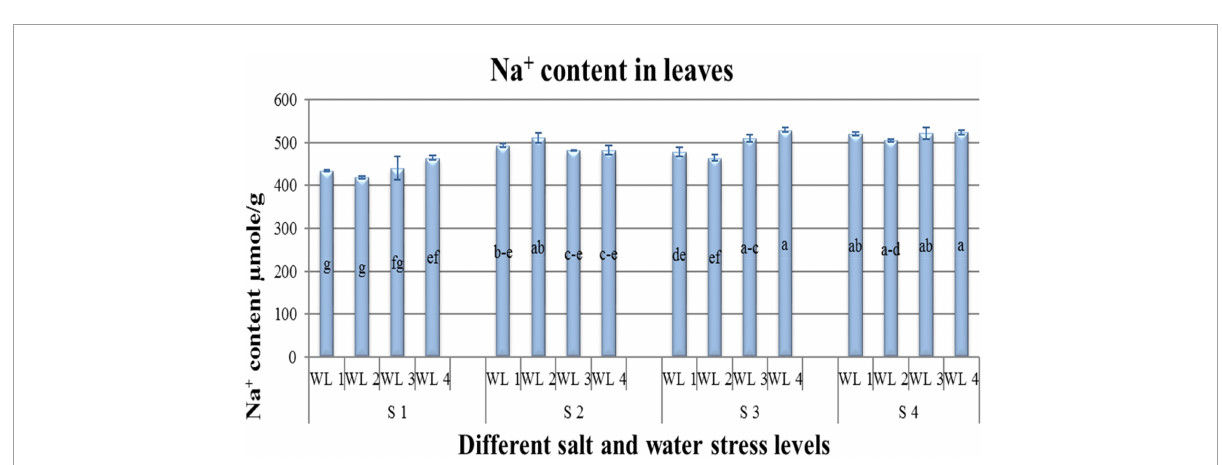
FIGURE2 Interactive effect of salinity and drought stress on Na + content of Atriplex leucoclada . The error bars represent the standard error of the mean ( n = 3). WL stands for water level (WL1 = 100% field capacity, WL2 = 80% field capacity, WL3 = 60% field capacity and WL4 = 40% field